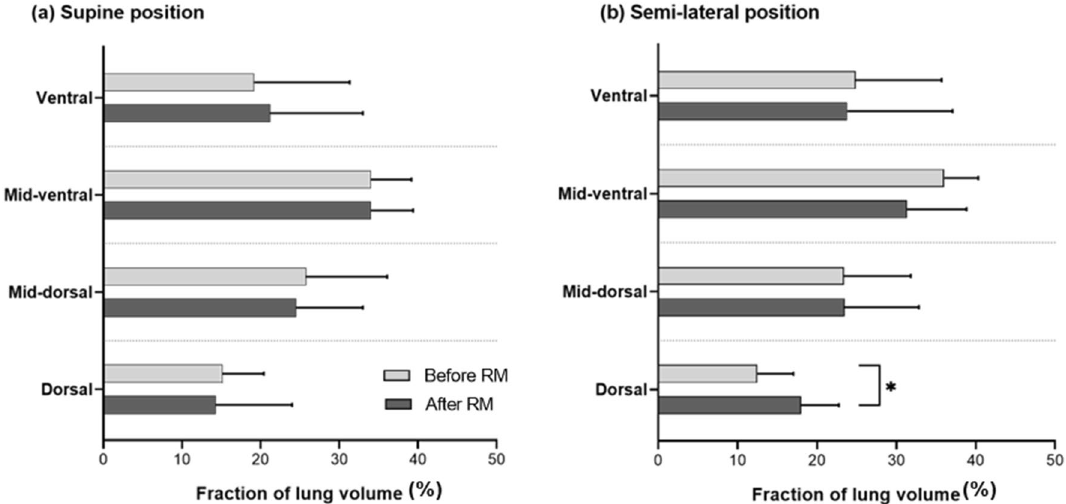
Figure 3. Changes in regional distribution of lung ventilation before and after the lung recruitment maneuver (LRM) in ( a ) supine position and ( b ) semi-lateral position. * P value < 0.05 by paired t test when comparing the regional distribution of lung ventilation in the dorsal division before and after the LRM. The bright gray bar indicates the fraction of lung ventilation before the LRM, while the dark gray bar indicates the fraction of lung ventilation after the